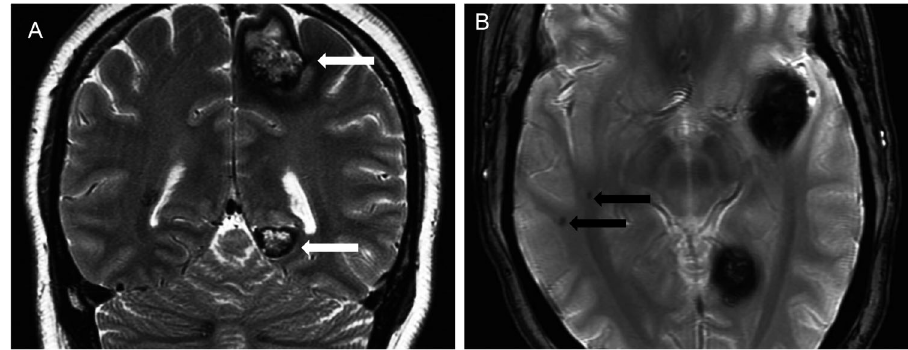
Figure 7 - Familial cerebral cavernous malformations caused by a KRIT1 gene mutation in a 36-year-old woman with multiple epileptic foci (video-EEG) and chronic partial epilepsy. A) Coronal T2-weighted images show the typical appearance of a type 2 cavernoma (white arrows) characterized by mixed signal intensity with a hemosiderin ring. B) An axial T2*-weighted gradient-echo sequence revealing two type 4 cavernomas (black arrows) in the right temporal lobe, only observed using this sequence.